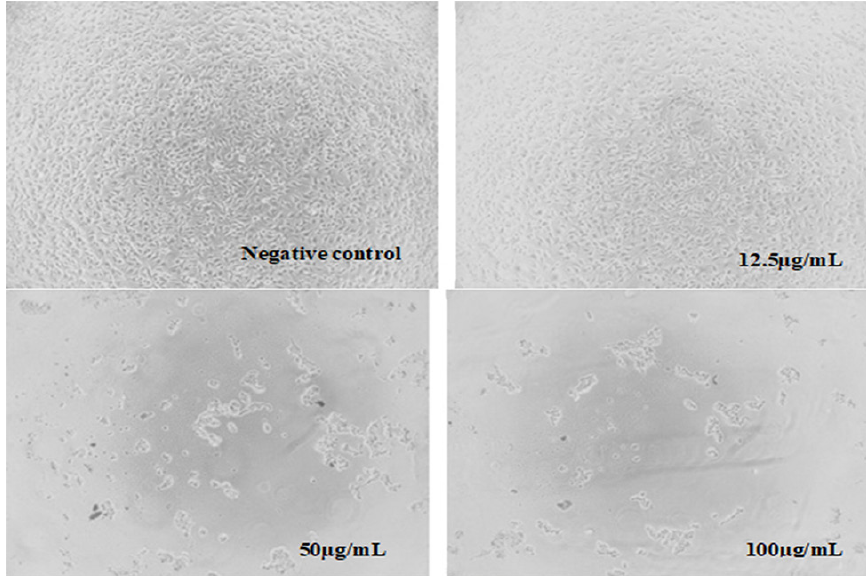
Figure 2 - Effect of H. courbaril extract on B16F10- Nex2 melanoma cell line for 48 h exposure period.